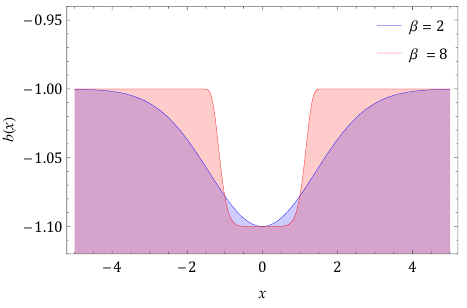
Figure 1. Nature of b ( x ) at β = 2 and